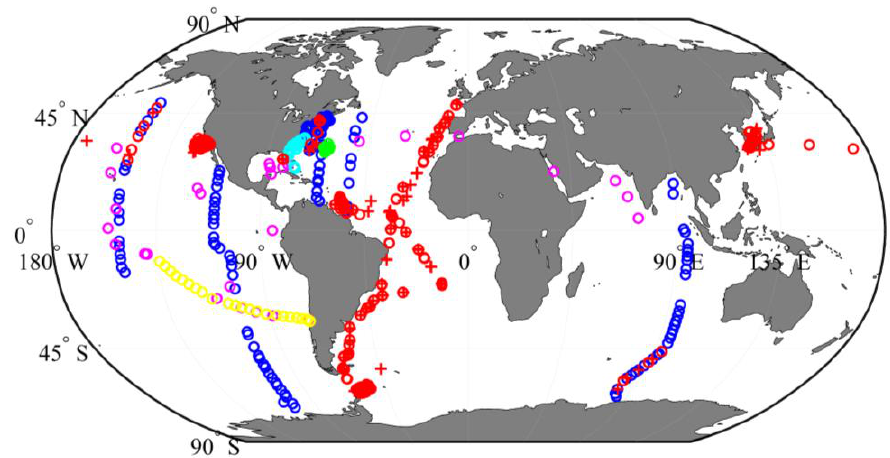
Figure 1. In situ data distribution, the ( o ) are the stations for quantitative filter technique (QFT) a ph ( λ ) from SeaBASS, ( o ) and ( + ) are the subset_1 and subset_2 stations of matchups of a ph ( λ ) and HPLC from SeaBASS, ( o ) is the HPLC location for BATS (Bermuda Atlantic Time-Series Study), ( o ) are the BIOSOPE R rs ( λ ), a ph ( λ ) and HPLC locations, ( o ) are locations of the R rs ( λ ), a ph ( λ ) and HPLC from VIIRS val/cal cruises in 2014 and 2015, and ( o ) are the locations of R rs ( λ ), a ph ( λ ) and HPLC from Tara Oceans expedition.